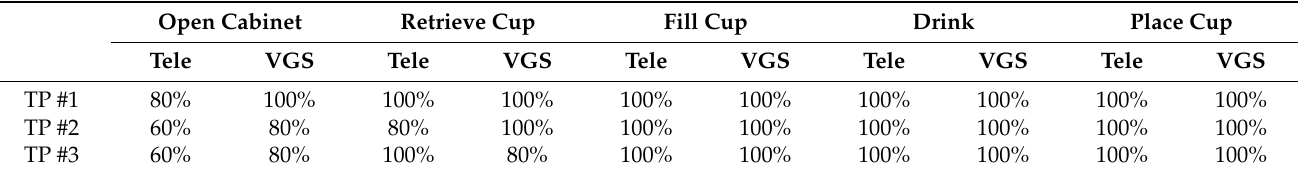
Table 3. Subtask success rate during teleoperation and VGS control.